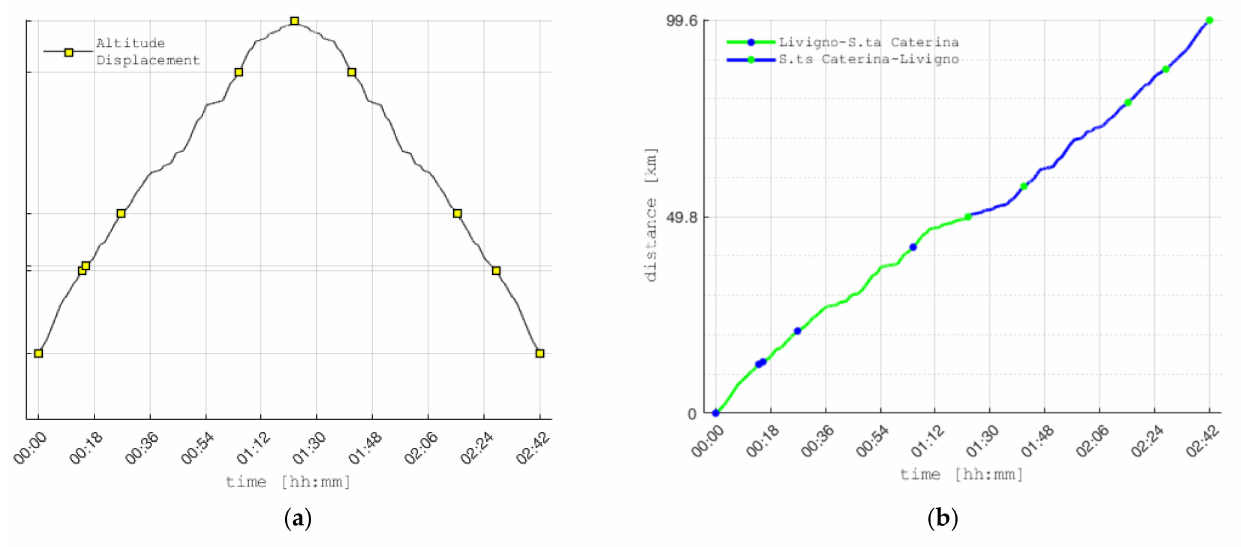
Figure 6. Distance profile ( a ) qualitative and ( b ) quantitative representation.